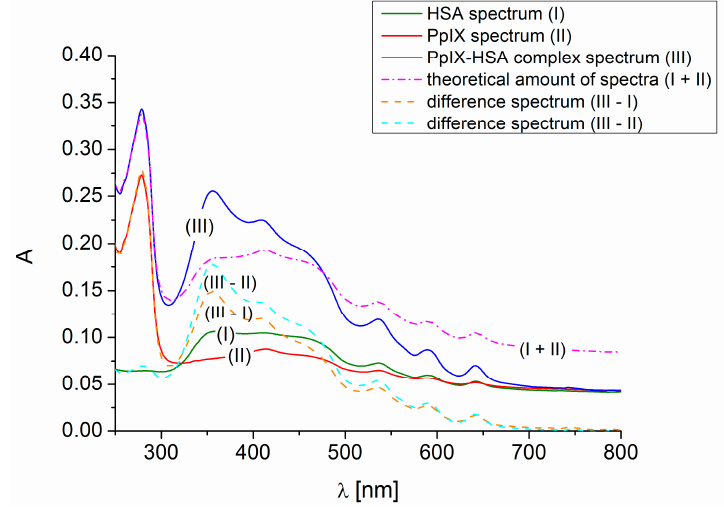
Figure 1. Difference spectra of protoporphyrin IX (PpIX) (5 × 10 − 6 M)-human serum albumin (HSA) (1 × 10 − 6 M) systems.